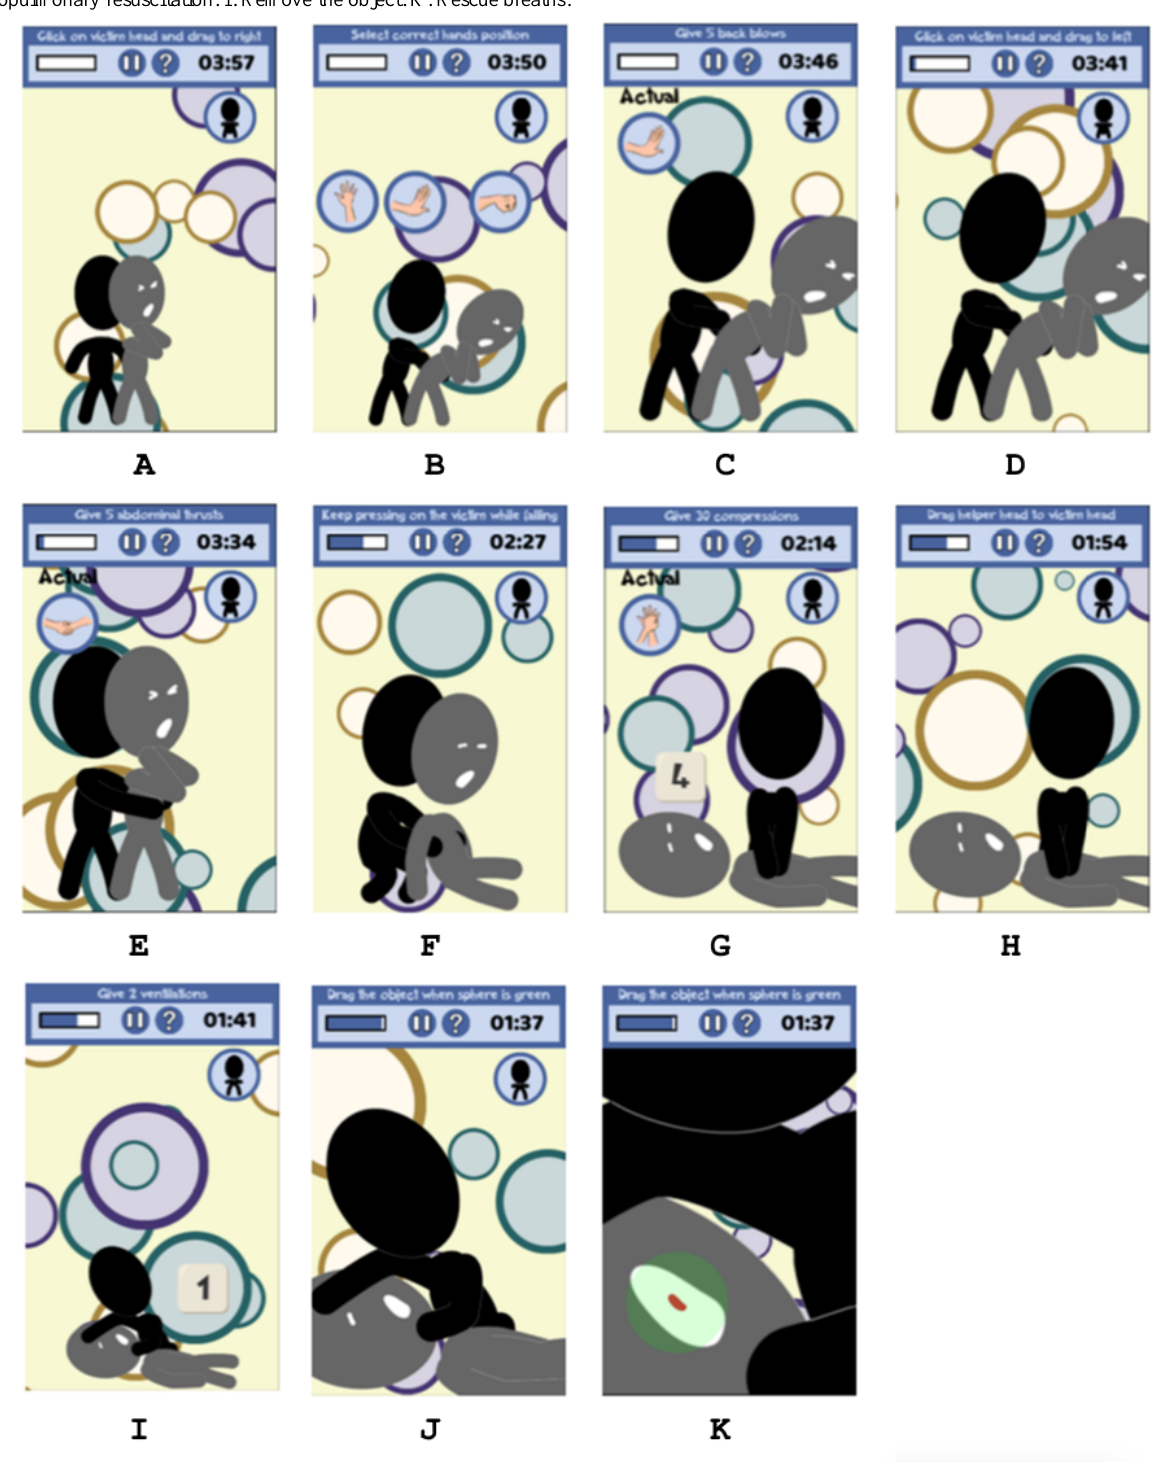
Figure 5. Choking maneuver screens corresponding to the different parts of the minigame. A-E. Back blows and abdominal thrusts. B, F, G, H, J. Cardiopulmonary resuscitation. I. Remove the object. K. Rescue